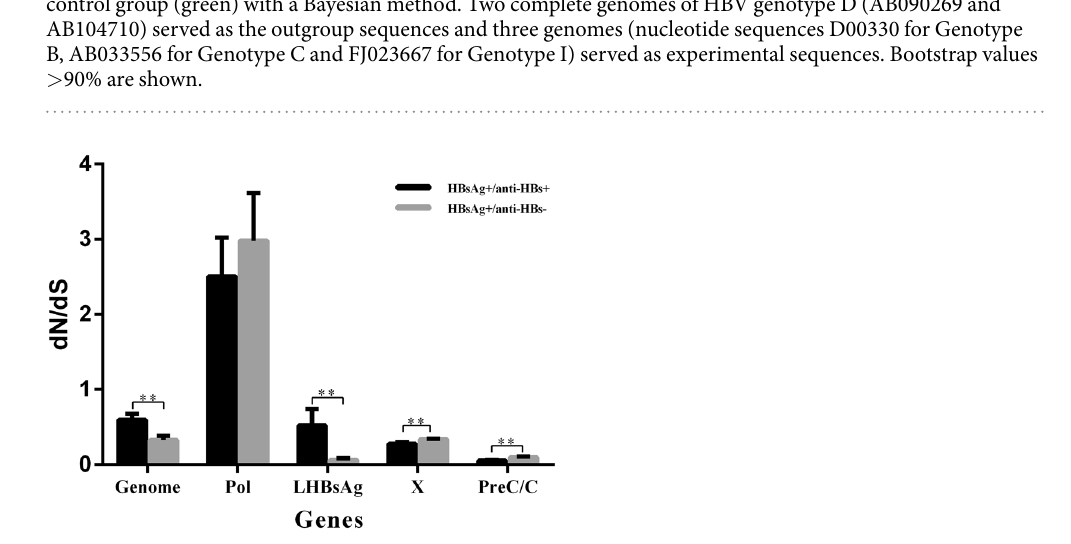
Figure 4. dN/dS ratios for HBV genes LHBsAg, Pol, HBxAg, and